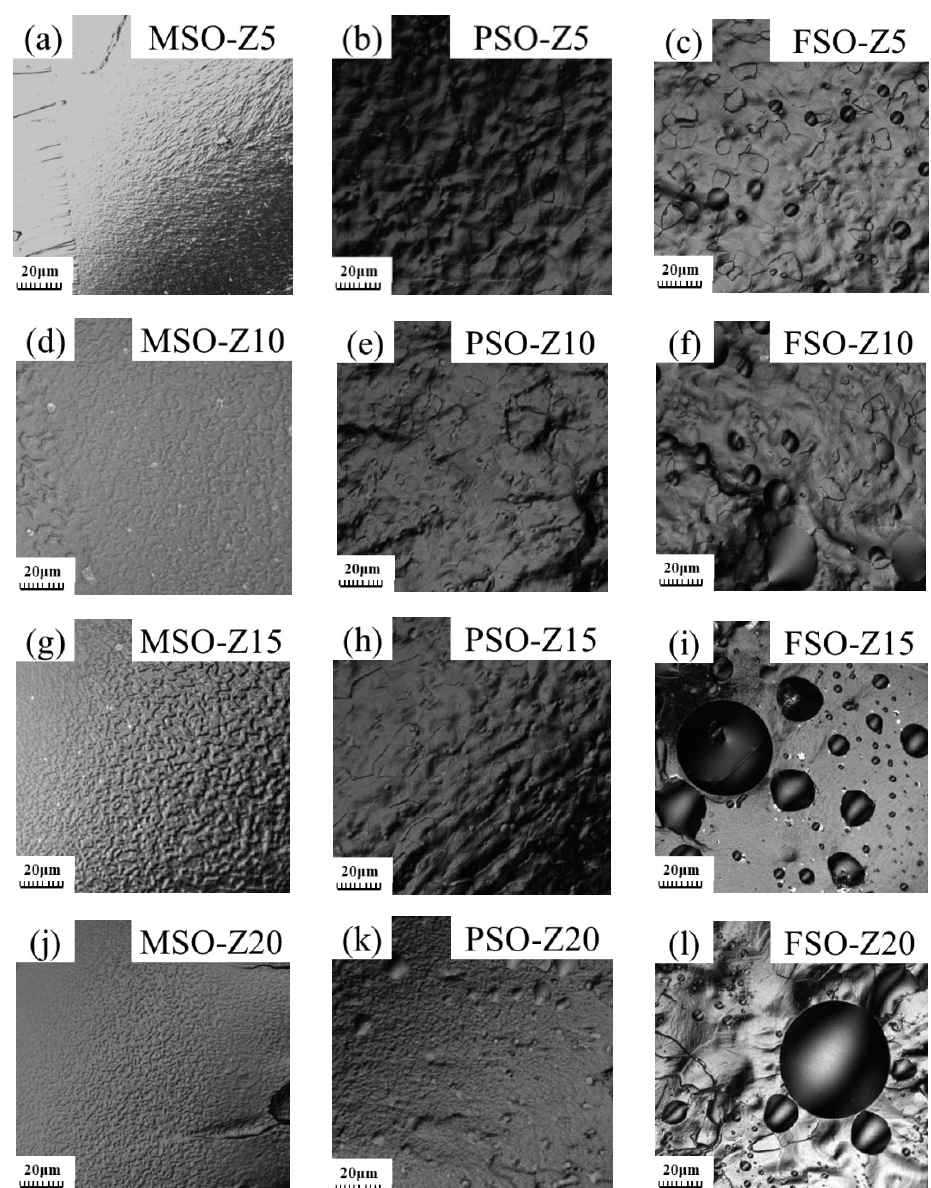
Figure 7. CLSM fracture morphology of different coatings: ( a ) MSO-Z5, ( b )PSO-Z5, ( c ) FSO-Z5, ( d )MSO-Z10,( e ) PSO-Z10, ( f ) FSO-Z10, ( g ) MSO-Z15, ( h ) PSO-Z15, ( i ) FSO-Z15, ( j ) MSO-Z20, ( k ) PSO-Z20, ( l ) FSO-Z20.